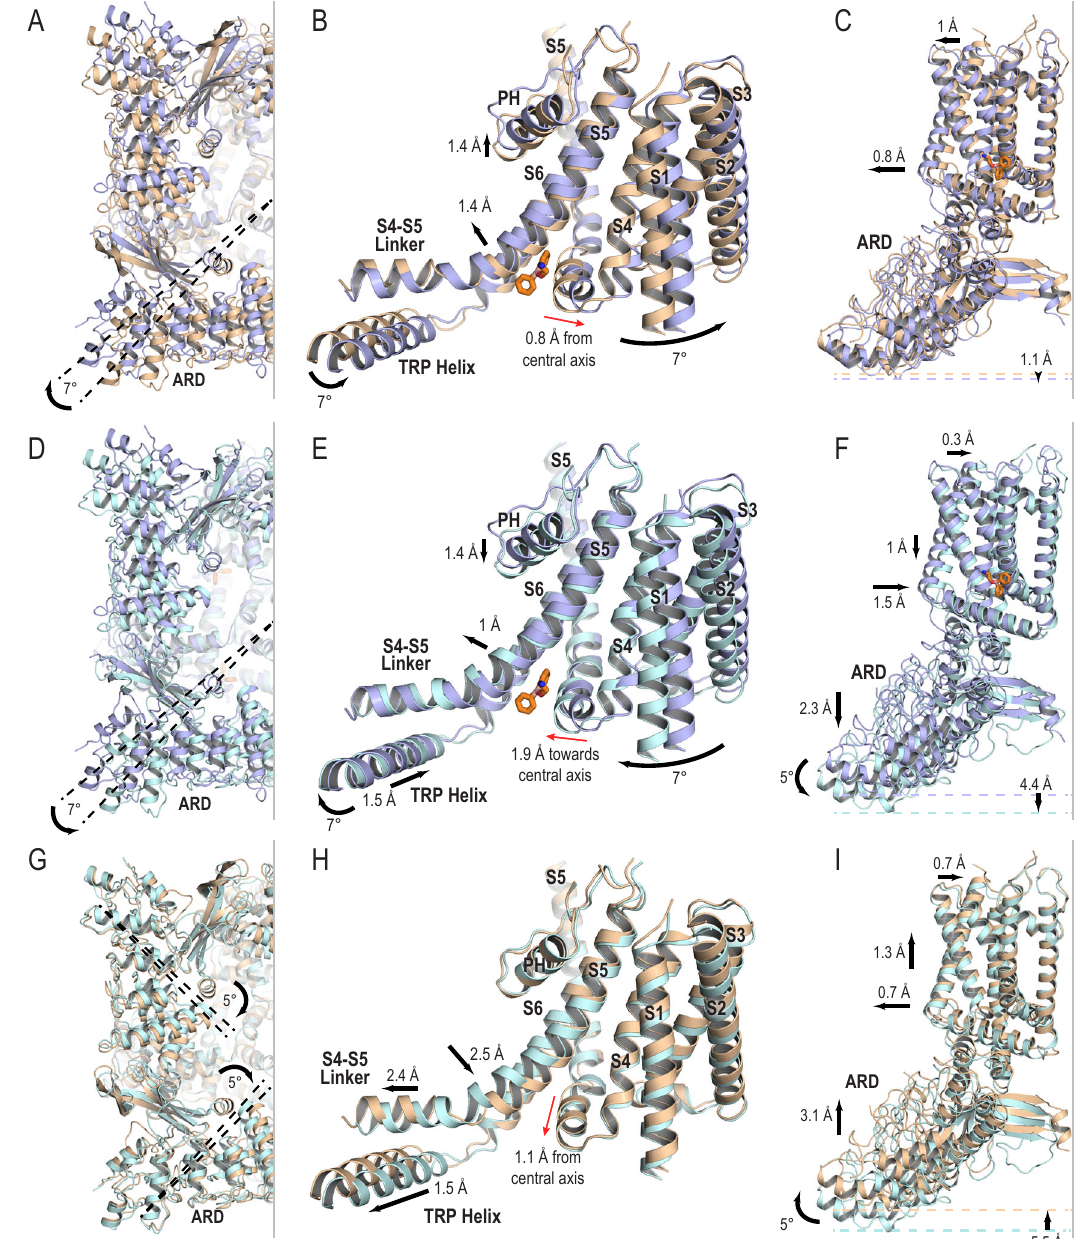
Fig. 4 Conformational changes in TRPV2 structure upon 2-APB binding. Cartoon representations comparing TRPV2 Apo1 (wheat, PDB 6U84), TRPV2 2APB_AC (light blue), and TRPV2 2APB_IAC (light cyan), the drug shown is from TRPV2 2APB_IAC ; models were aligned to S6. A , D , G View from the cytoplasmic side of TRPV2 showing the rotation of the ARDs as the channel transitions through the gating cycle. B , E , H The channel movements during gating originate from the 2-APB binding site. C , F , I View from the side of TRPV2 showing conformational changes in the TMD and ARDs through the gating